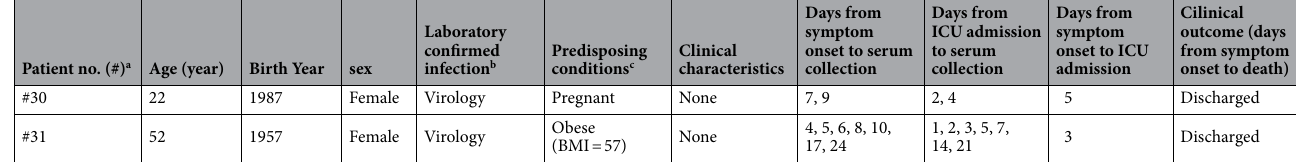
Kinetics of anti-HA antibody responses against A(H1N1)pdm09 virus antigens in 8 patients with multiple days of serum collections available (S1 at ≤ 7 dpo and the last samples at ≥ 14 dpo) were analyzed (Fig. 2a,b).